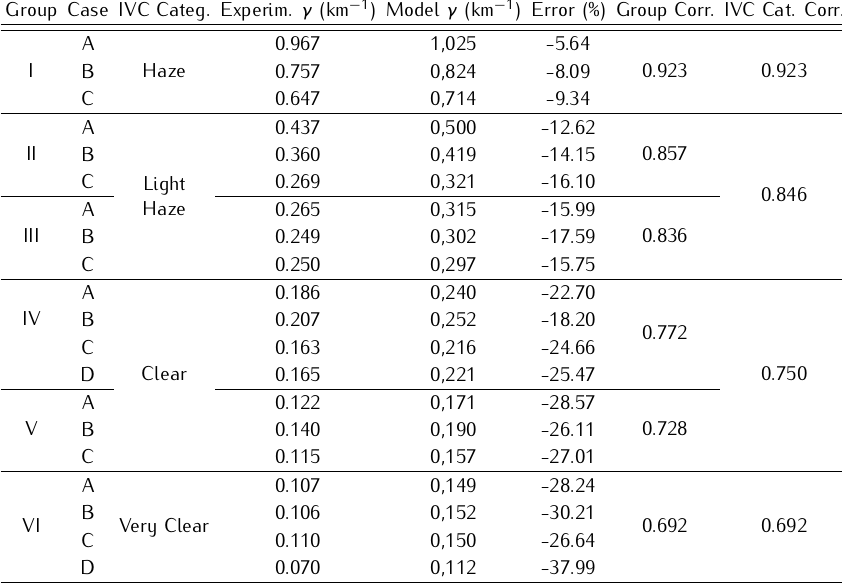
Table 12. Transmittance data and ESLM model corrections ( λ = 1064 nm – SR = 2.5 km).